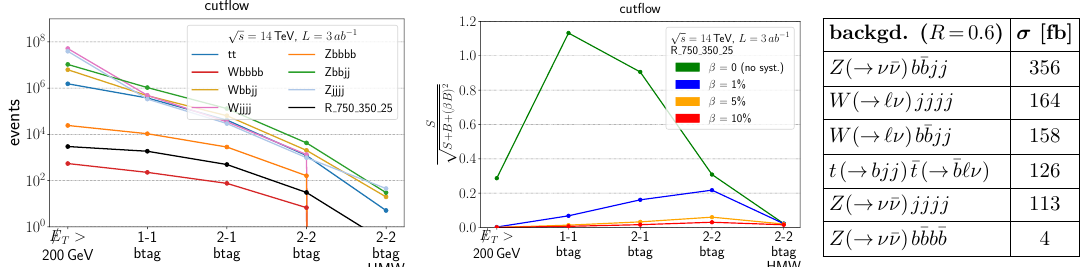
Figure 6 . Cut(cid:13)ow (left panel) and signi(cid:12)cance (cid:6) (center panel) for the cut-based analysis of the resonant model R 750 350 25. Right panel: cross section of dominant backgrounds for =E 200 GeV, after applying a lepton veto and requiring 1-1 b -tagging, i.e., at least one b -tagged subjet from each fat jet with radius R = 0 :